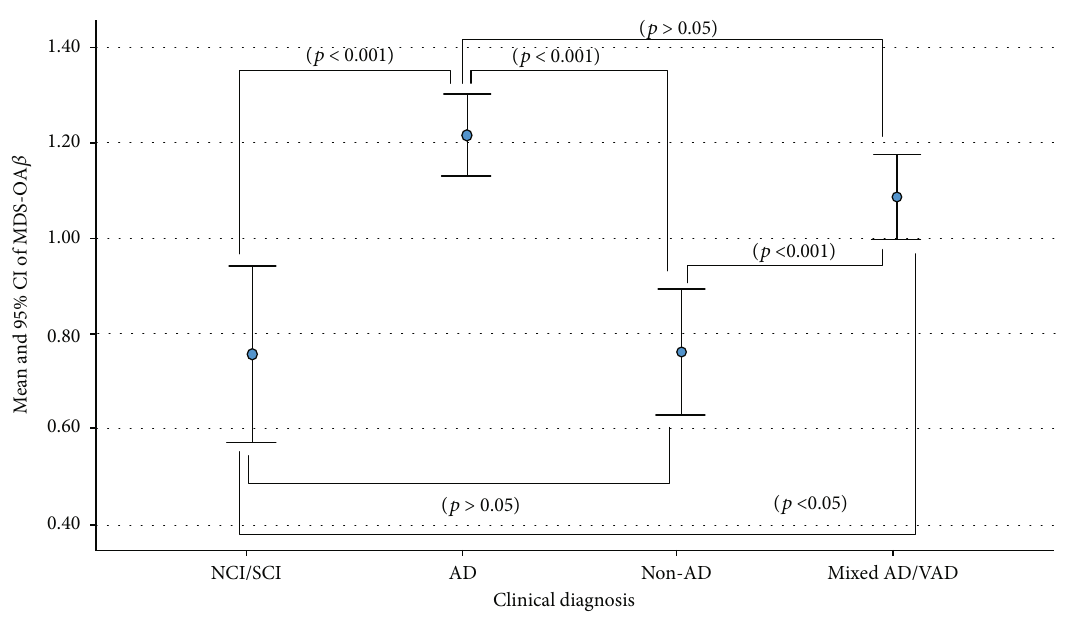
Figure 2: Comparison of the mean and 95% CI of MDS-OA β per clinical